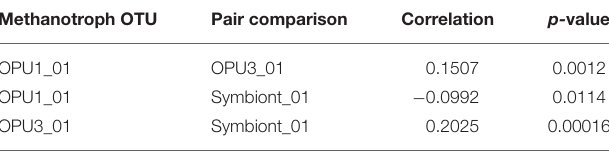
TABLE 1 | Multivariate regression statistics for methanotroph OTUs. Methanotroph